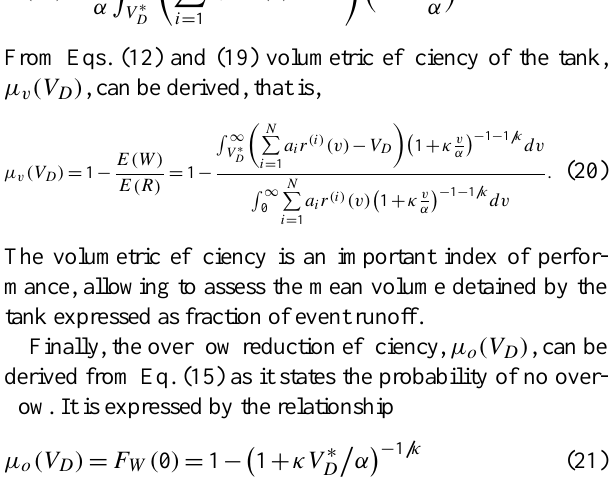
Fig. 3. System elements: rainfall, runoff and